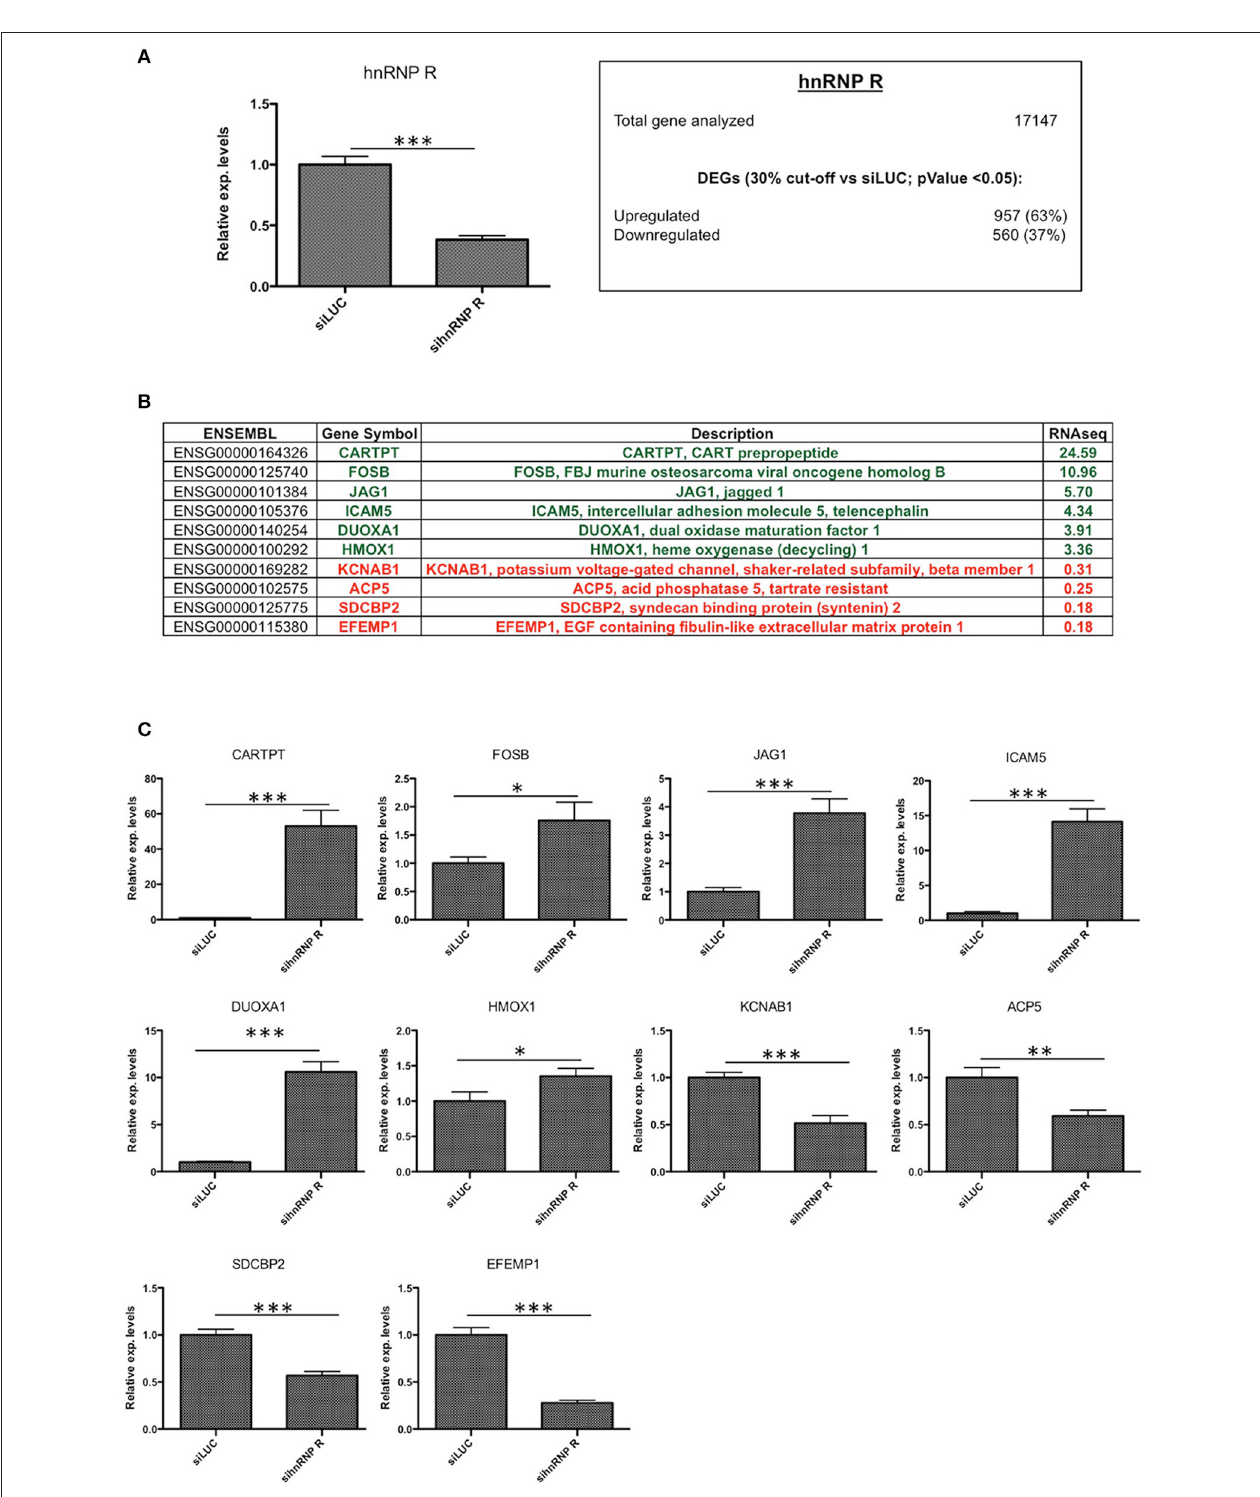
FIGURE 4 | Validation of hnRNP R silencing and comparison between RNA-seq and RT-qPCR results. (A) Assessment of hnRNP R siRNA silencing efficiency using qPCR (*** p < 0.001) and summary of differentially expressed genes (DEGs with p < 0.05) with number of downregulated ( < 0.7x vs. siLUC) and upregulated ( > 1.3x vs. siLUC) genes after sihnRNP R treatment. (B) List of DEGs validated by RT-qPCR and associated with brain functions/neurodegeneration (CARTPT, FOSB, JAG1, DUOXA1, HMOX1, KCNAB1, SDCBP2, EFEMP1), inflammation (ICAM5, ACP5). (C) RT-qPCR validation of 10 selected transcripts. Each bar reports mean ± standard error of three independent experiments. Statistical differences were evaluated using t-students (* p < 0.05, **p < 0.01, *** p < 0.001).